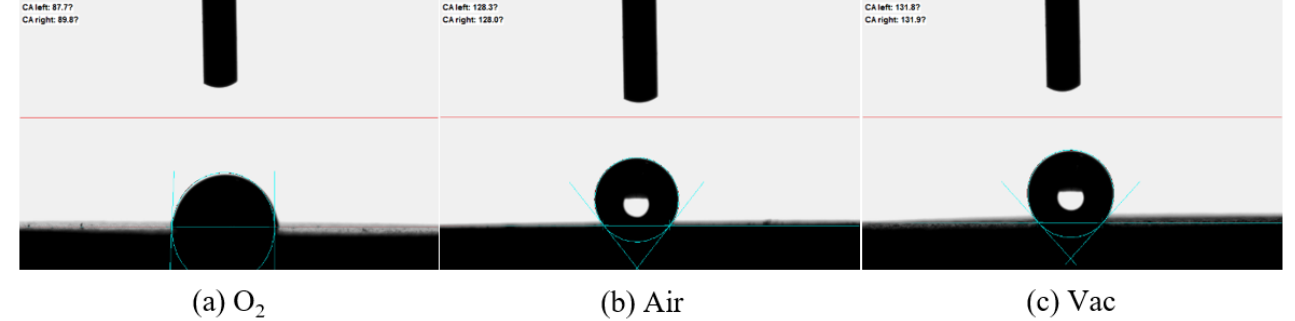
Figure 11. The contact angle images for CP-Ti with different atmospheres after 27 days holding time. ( a ) O2, ( b ) Air, ( c ) Vacuum.